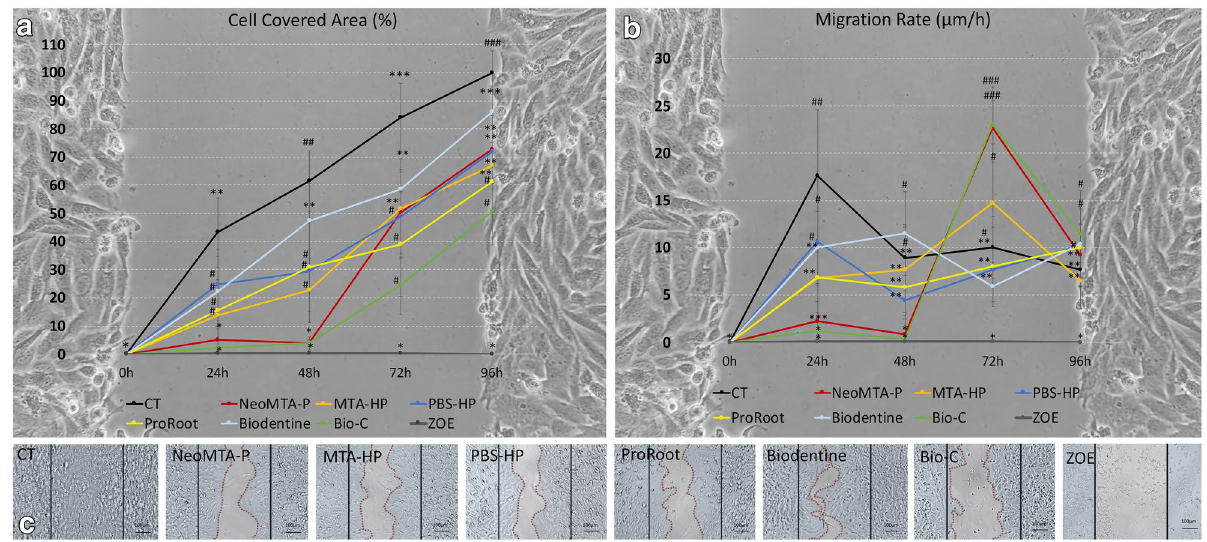
Figure 2. ( a – c ) Wound area covered by cells, cell migration rates, and representative images of the cells after 96 h of exposure. The surface areas of the wound covered by the osteoblastic cells exposed to the reparative cements were significantly smaller than the control group of unexposed cells (CT) at all times evaluated ( a ). Impairment of cell migration could be observed at 24 h in the calcium silicate-based cement groups, suggestive of environmental stiffness ( b ). Osteoblastic cells exposed to NeoMTA-P and Bio-C for 24 and 48 h showed a significantly lower migration rate than the other groups, especially when compared to CT. From 48, 72, to 96 h, the migration rates of the osteoblastic cells exposed to MTA-HP, PBS-HP, ProRoot, and Biodentine were similar to that of CT. The cells exposed to NeoMTA-P and Bio-C showed a significant increase in migration rates only after 72 h of exposure ( b ). At 96 h, the unexposed cells (CT) showed complete closure of the wound area. However, the cells exposed to NeoMTA-Plus, MTA-HP, PBS-HP, ProRoot, Biodentine, and Bio-C did not migrate enough to close the wound gap ( c ). Interestingly, the cell morphologies were typical without evident signs of cytotoxicity except for the comparator group (ZOE), which showed dead cells and a completely open area ( c ). Micrographs at ×20, 100 µm bars ( c ). The backgrounds in ( a , b ) are representative images of the wound healing at the initial time (T0). Data are presented as mean ± SD of area covered by cells ( a ) and migration rates ( b ) at each exposure time; two-way ANOVA followed by multiple comparisons post-hoc test with Bonferroni’s posttest. Symbols on the charts indicate homogeneous groups by Bonferroni’s posttest. ( a ) *p < 0.001, all groups within the different times of exposure versus CT (0 h); # p < 0.02, cement groups versus each other within the different times of exposure; **p < 0.05, all groups within the different times of exposure versus CT (24 h); ## p < 0.03, all groups within the different times of exposure versus CT (48 h); ***p < 0.02, all groups within the different times of exposure versus CT (72 h); and ### p < 0.005, all groups within the different times of exposure versus CT (96 h). ( b ) *p < 0.001, all groups within the different times of exposure versus CT (0 h); # p < 0.05, all groups versus each other within the different times of exposure; **p < 0.03, all groups versus each other within the different times of exposure; ## p < 0.02, all groups within the different times of exposure versus CT (24 h); ***p < 0.02, NeoMTA-P (24 h) versus all groups within the different times of exposure; and ### p < 0.001, NeoMTA-P and Bio-C (72 h) versus all groups within the different times of